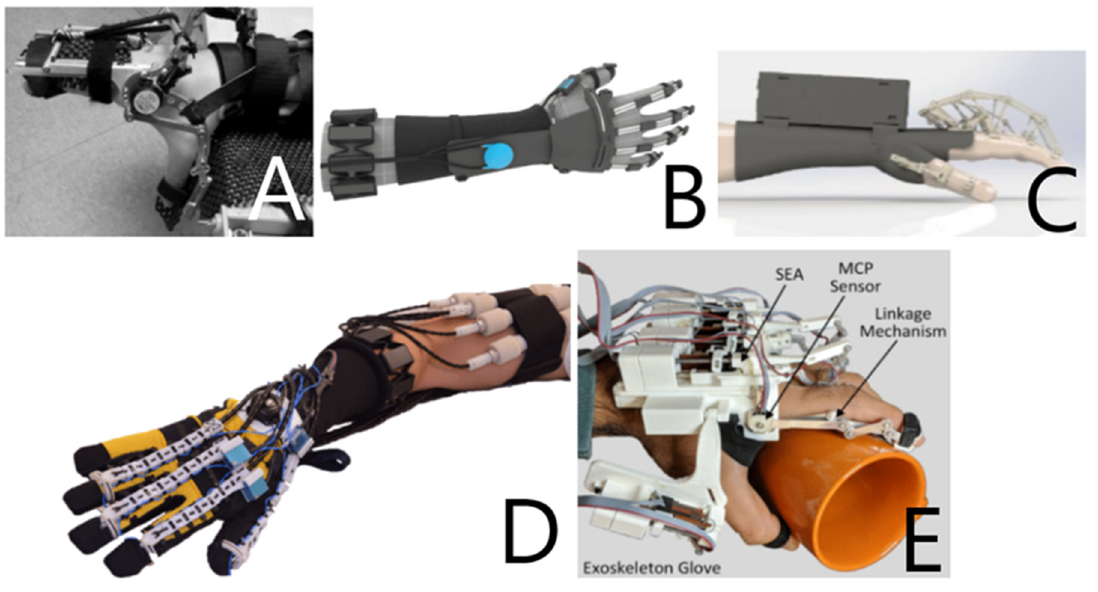
Figure 4. ( A ) HandSOME [45], ( B ) RELab Tenoexo [48], ( C ) hand exoskeleton for post-stroke patients [50], ( D ) hybrid rigid–soft hand exoskeleton to assist functional dexterity [53], and ( E ) naturalistic exoskeleton glove [54].